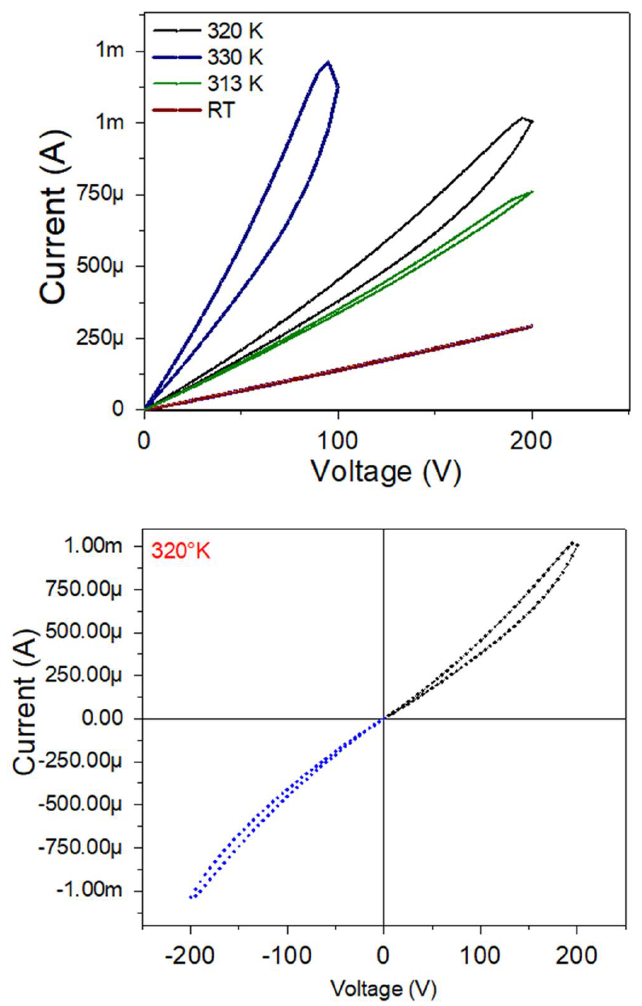
Figure 15. I-V curves for a BFO/VO 2 /Al 2 O 3 bilayer, with a BFO layer of 30 nm with different temperatures ( up ) and at 320 K with positive and negative voltage values ( down ).